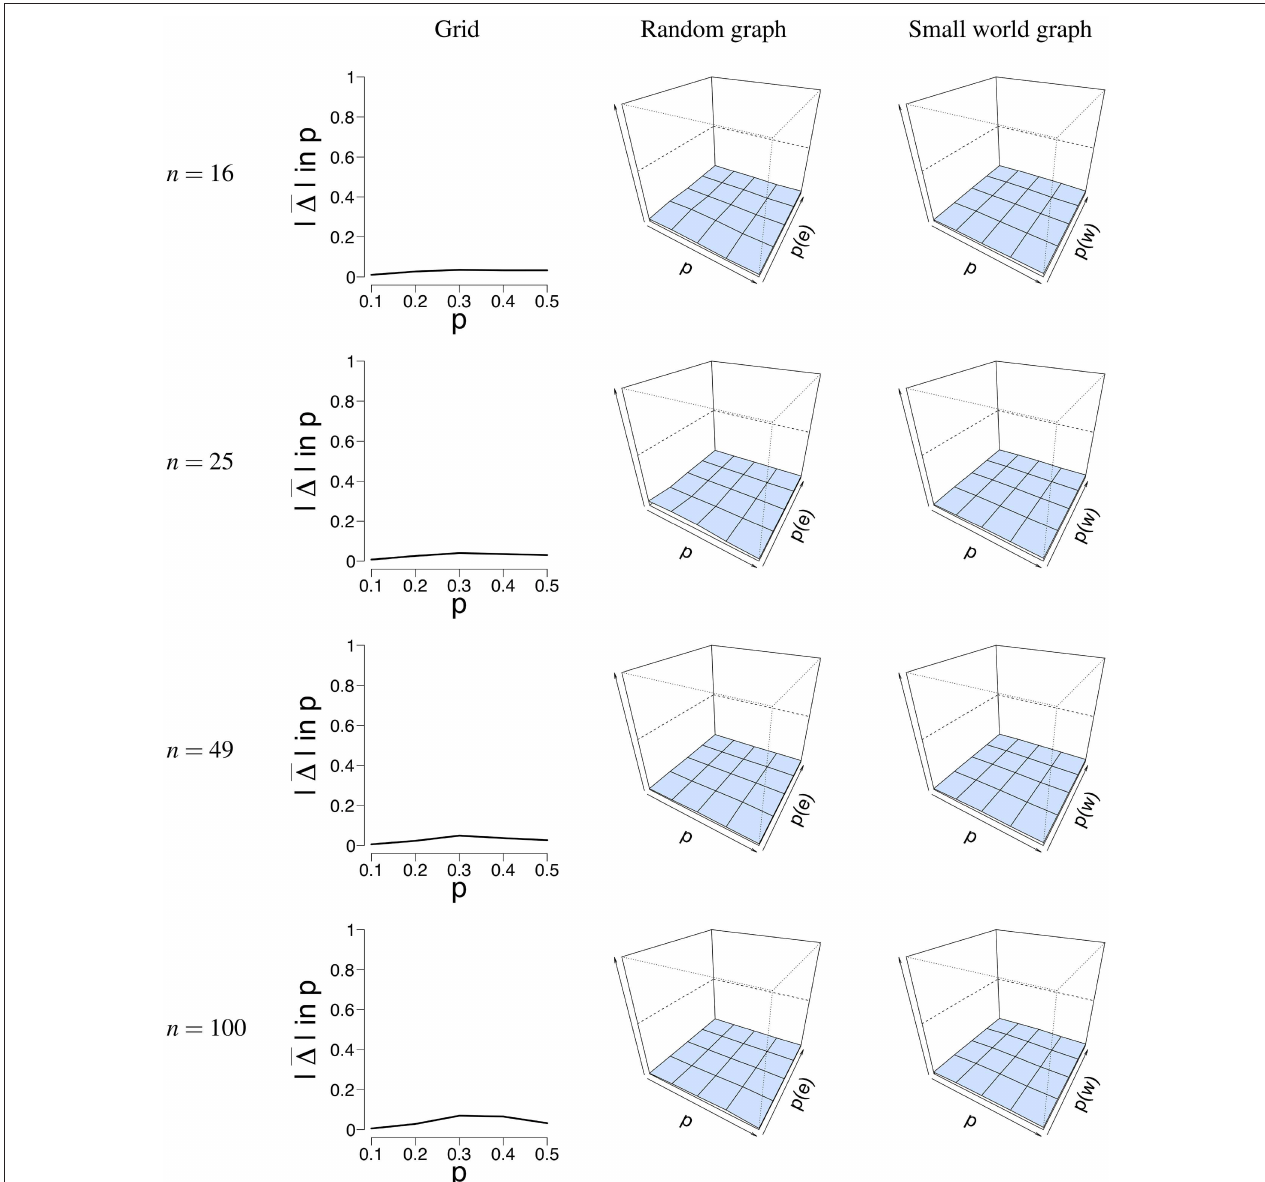
FIGURE 5 | Visualization of the mean error rate between p and ˆ p . Mean absolute difference ( | 1 | ) is shown for a grid (Left column) , a random graph (Middle column) , and a small world graph (Right column) at T = 50. For the left column, the x -axis denotes the parameter p for which we simulated data, and the y -axis the mean absolute difference | 1 | between p and ˆ p . For the middle and right column, the x -axis denotes the parameter p for which we simulated data, the z -axis the graph parameter that was used to simulate data ( p ( e ) or p ( w )), and the y -axis the mean absolute difference | 1 | between p and ˆ p . The mean absolute difference ranges between 0 and 1, where a lower value indicates a smaller difference between p and ˆ p .